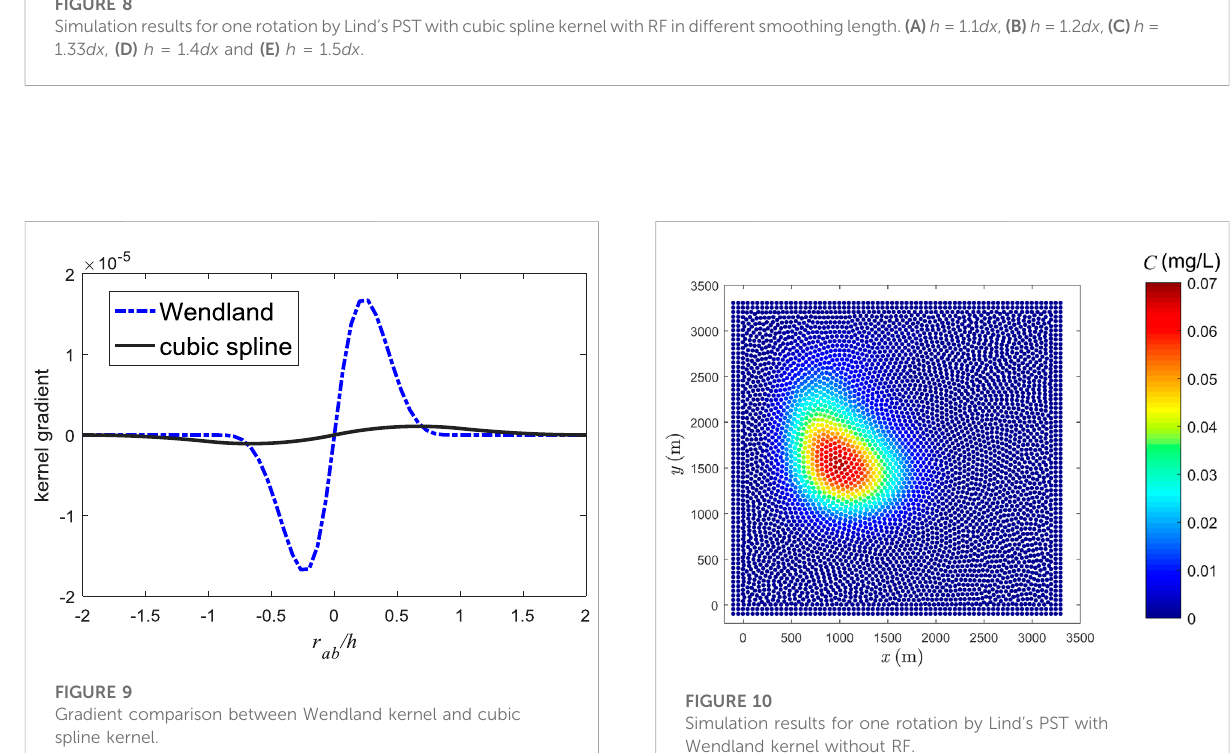
FIGURE 9 Gradient comparison between Wendland kernel and cubic spline kernel.